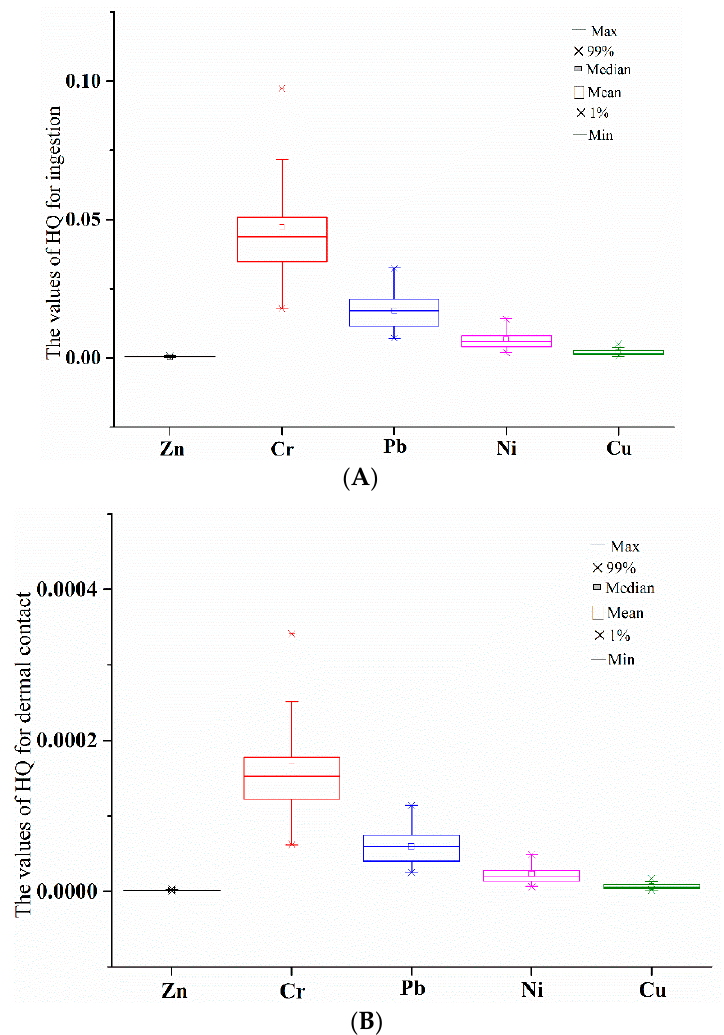
Figure 5. Human health risks of single heavy metals posed through pathways of ingestion ( A ) and dermal contact ( B ). HQ, hazardous quotient.